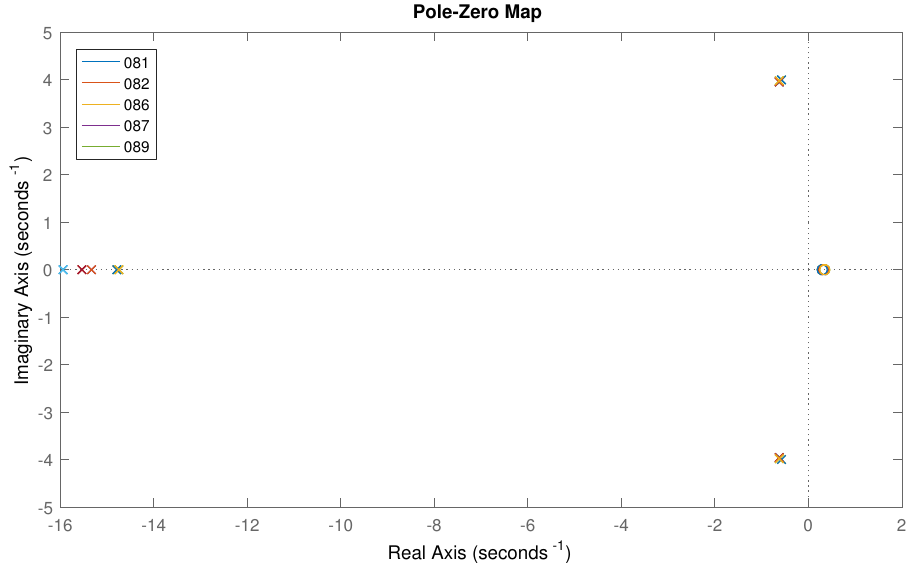
Figure 21. Pole-Zero maps of the intrinsic admittance with zero friction Y 0 i